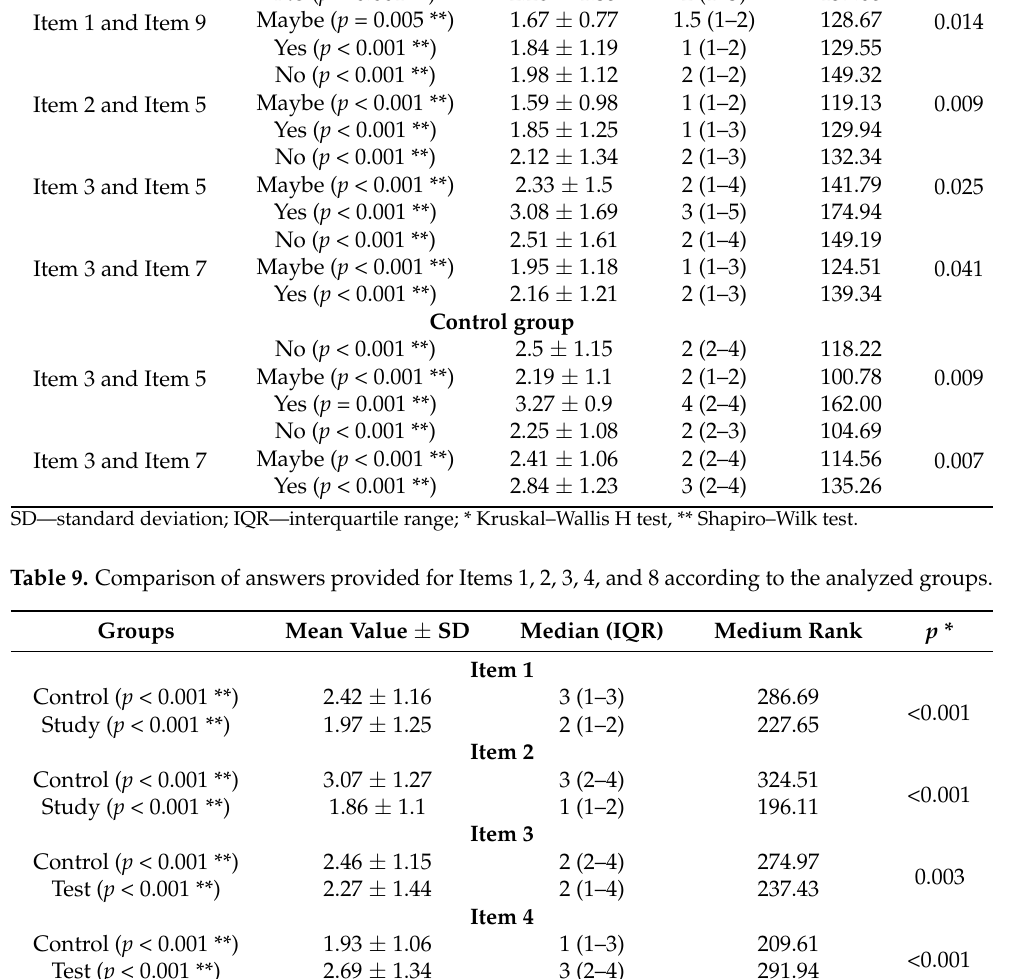
Table 10. Comparison of answers provided for Items 5, 6, and 7 according to the analyzed groups.